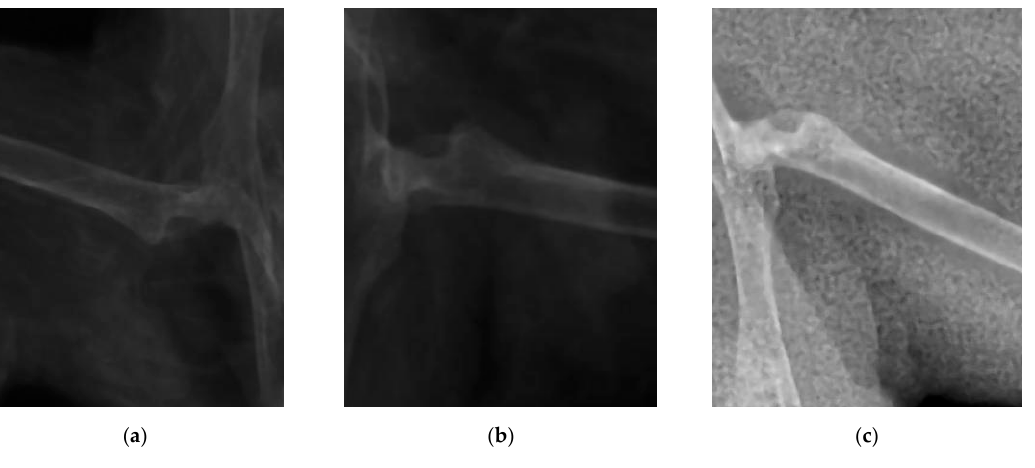
Figure 3. An X-ray image femoral bones in mice: ( a ) mice receiving feed supplement containing silicon chelates (Group 1); ( b ) mice receiving feed supplement containing silicon chelates and vitamin D (Group 2); ( c ) mice receiving food without any supplements (Control group). Table 7. The cortical thickness index of ICR mice receiving feed supplement containing silicon chelates and vitamin D upon physiological decalcification of bone tissue.